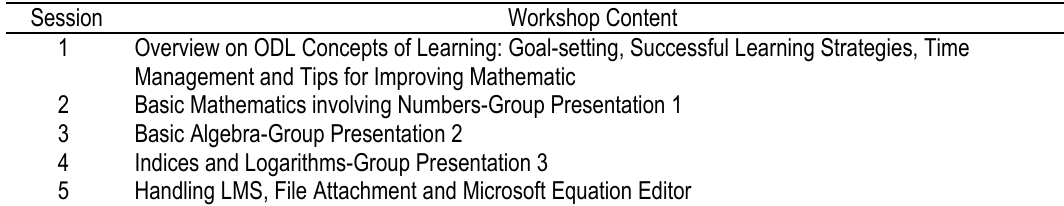
Table 1. Structure of the Pre-Instructional